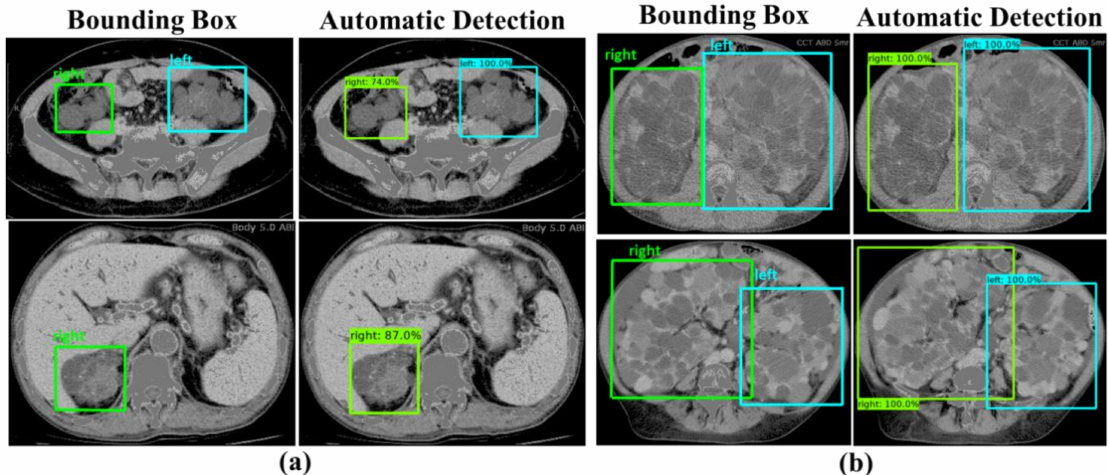
Figure 11. Detection results: ( a ) Small size of ADPKD kidneys; ( b ) Big size of ADPKD kidneys.